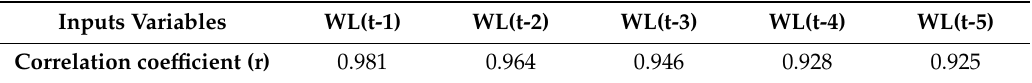
Table3. Pearsoncorrelationcoe ffi cient(R)betweeninputvariablesandbedloadsedimenttransportrate.